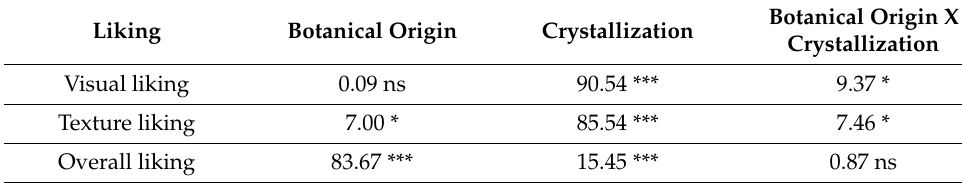
Table 10. ANOVA factorial